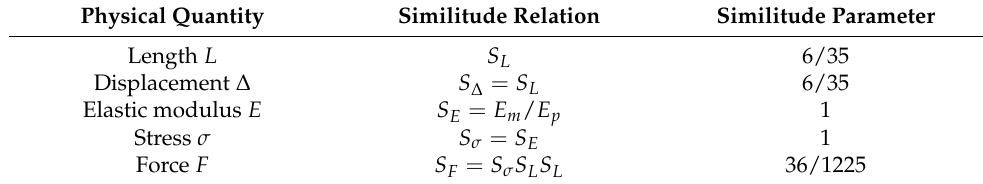
Figure 2. Dimension and configuration of PFRC-1 and PFRC-2. ( a ) Dimensions, ( b ) Configurations of columns, ( c ) A-A section, ( d ) B-B section. Table 2. Similitude relation in design